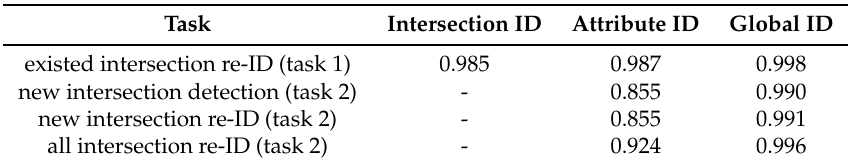
Table 6. Precision of proposed method under panoramic image modality in dealing with existed and new intersection images, which corresponds to the two main tasks in this